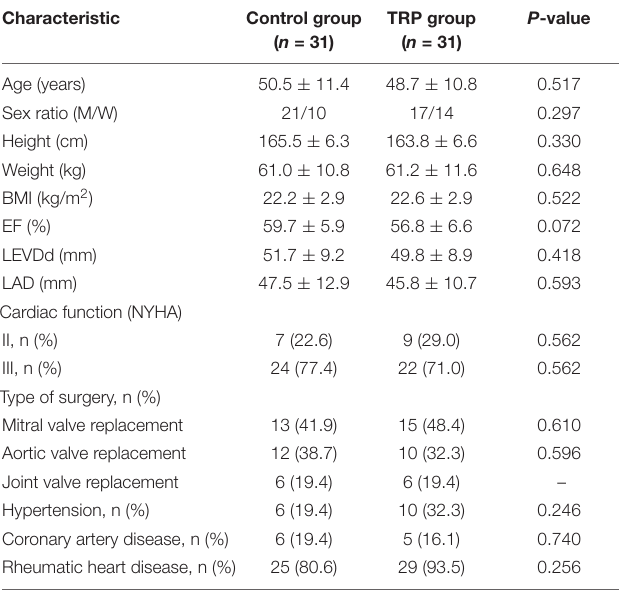
TABLE 1 | Patients baseline characteristics.